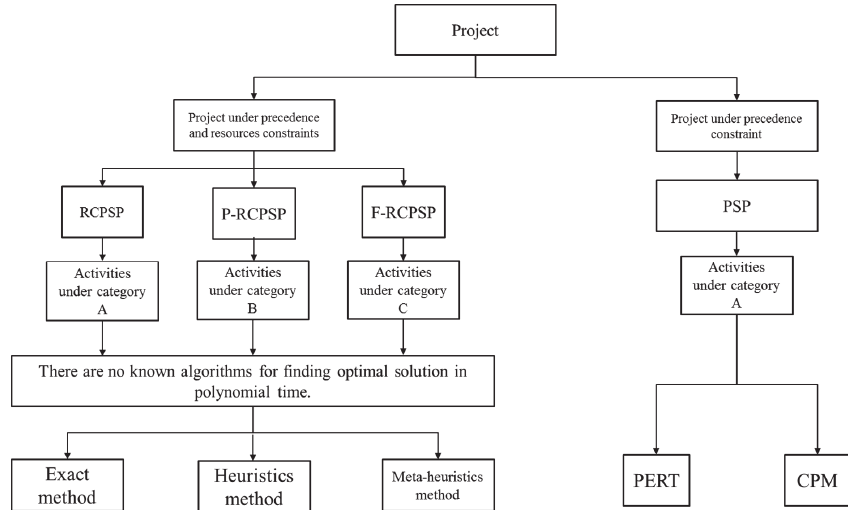
Fig. 5. The classifications of the project and multi-project scheduling problems